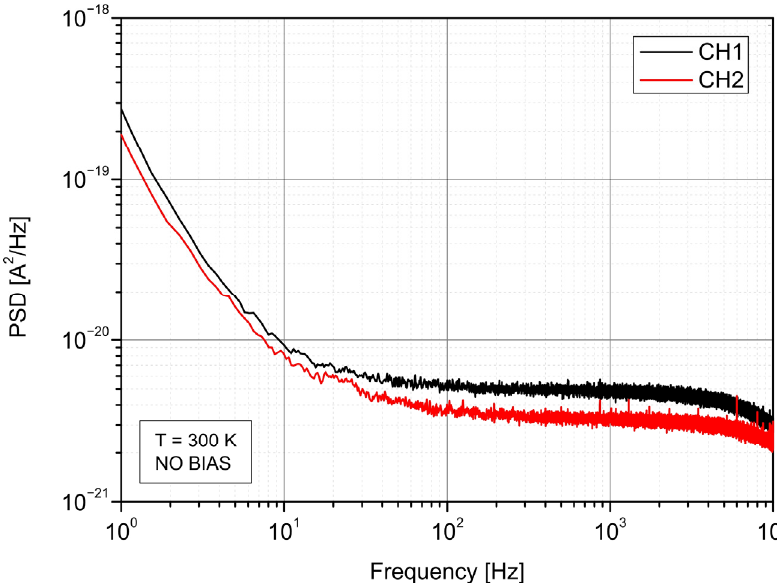
Figure 5. Spectral density of noise power of the designed channels.